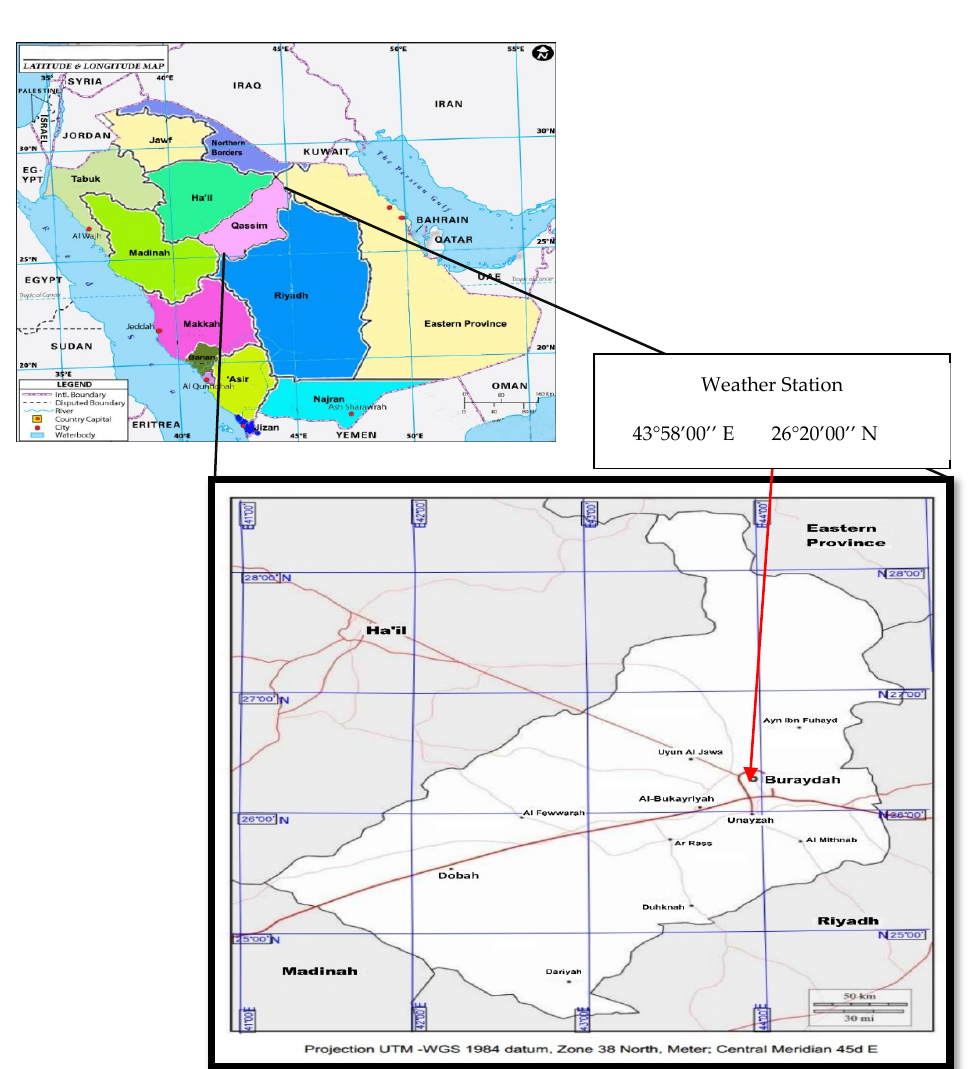
Figure 2. Map showing the location of the Weather Station in Qassim Region in the Kingdom of Saudi Arabia.